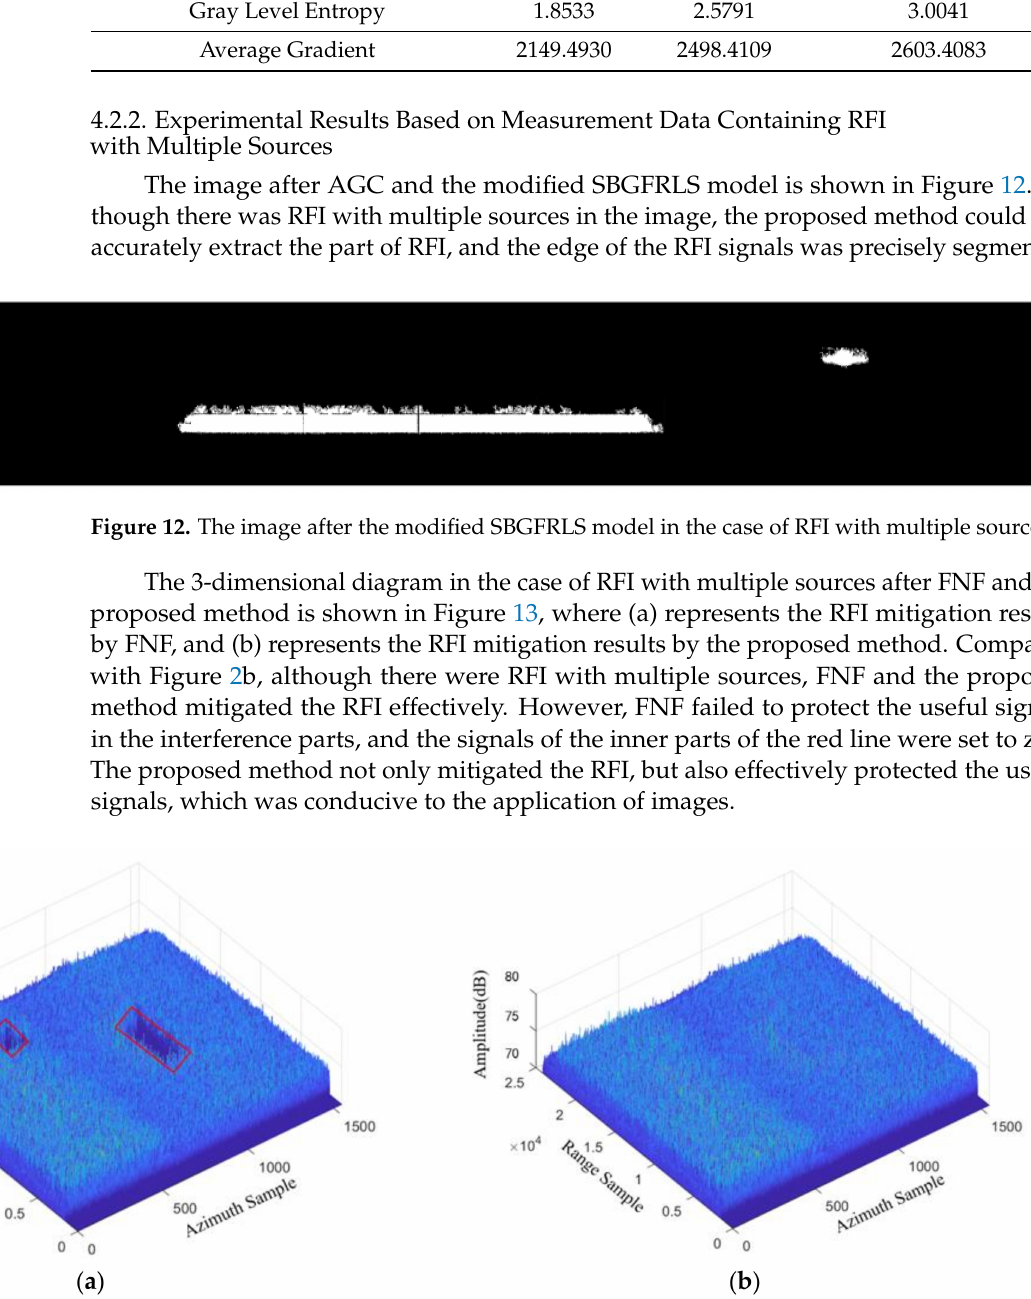
Figure 13. The 3-dimensional diagram in the range-frequency and azimuth-time domain after RFI mitigation: ( a ) FNF; ( b ) the proposed